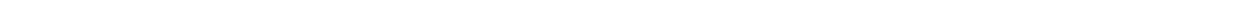
Fig. 5 Transcriptome comparison of pure whole IAHCs mechanically picked-up inside the aorta. a E10 embryo slices embedded in agarose. Scale bar, 5 mm. b Close-up showing an embryo slice. Scale bar, 1 mm. c Close-up showing c-kit + IAHCs attached to the aortic endothelium of an E10 embryo slice (left panel, bright fi lter (BF); right panel, c-kit fl uorescence). Scale bar, 50 μ m. d Two examples (upper and lower panels) of single IAHCs mechanical pick-up. Before pick-up, IAHCs were attached to the ventral side of the aorta (left panel, arrow). After pick-up, IAHCs were no longer visible in the aorta (right panel, arrow). e Example of a single mechanically picked-up IAHC (whole IAHC or wIAHC). Upper panel, BF; lower panel, c-kit fl uorescence. f Presence of a wIAHC (arrow) and contaminating single cells (asterisk) after wIAHC fi rst pick-up. g The wIAHC was picked-up a second time to eliminate the contaminating cells that remained in the medium drop (asterisk). h , i Box plots showing the RaceID cluster contribution to E11 ( h ) and E10 ( i ) wIAHCs. Color-coded boxes are related to RaceID analysis shown in Fig. 2d and Fig. 3c, respectively. j , k Probability for each cell to contribute to single wIAHCs at E11 ( j ) and E10 ( k ). Each horizontal line depicts a single wIAHC. The size of the circle is proportional to the probability for the cell at that position in pseudotime to contribute to that particular wIAHC. The number (next to the y -axis, inside the graph) depicts the total number of cells present in that particular wIAHC. l , m Probability density along pseudotime for contributing to